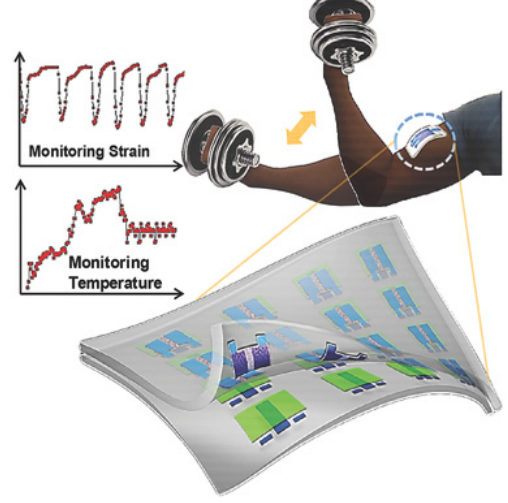
Figure 10. A transparent stretchable (TS) gated sensor array with high optical transparency (adapted from Reference [44] with permission from Wiley).